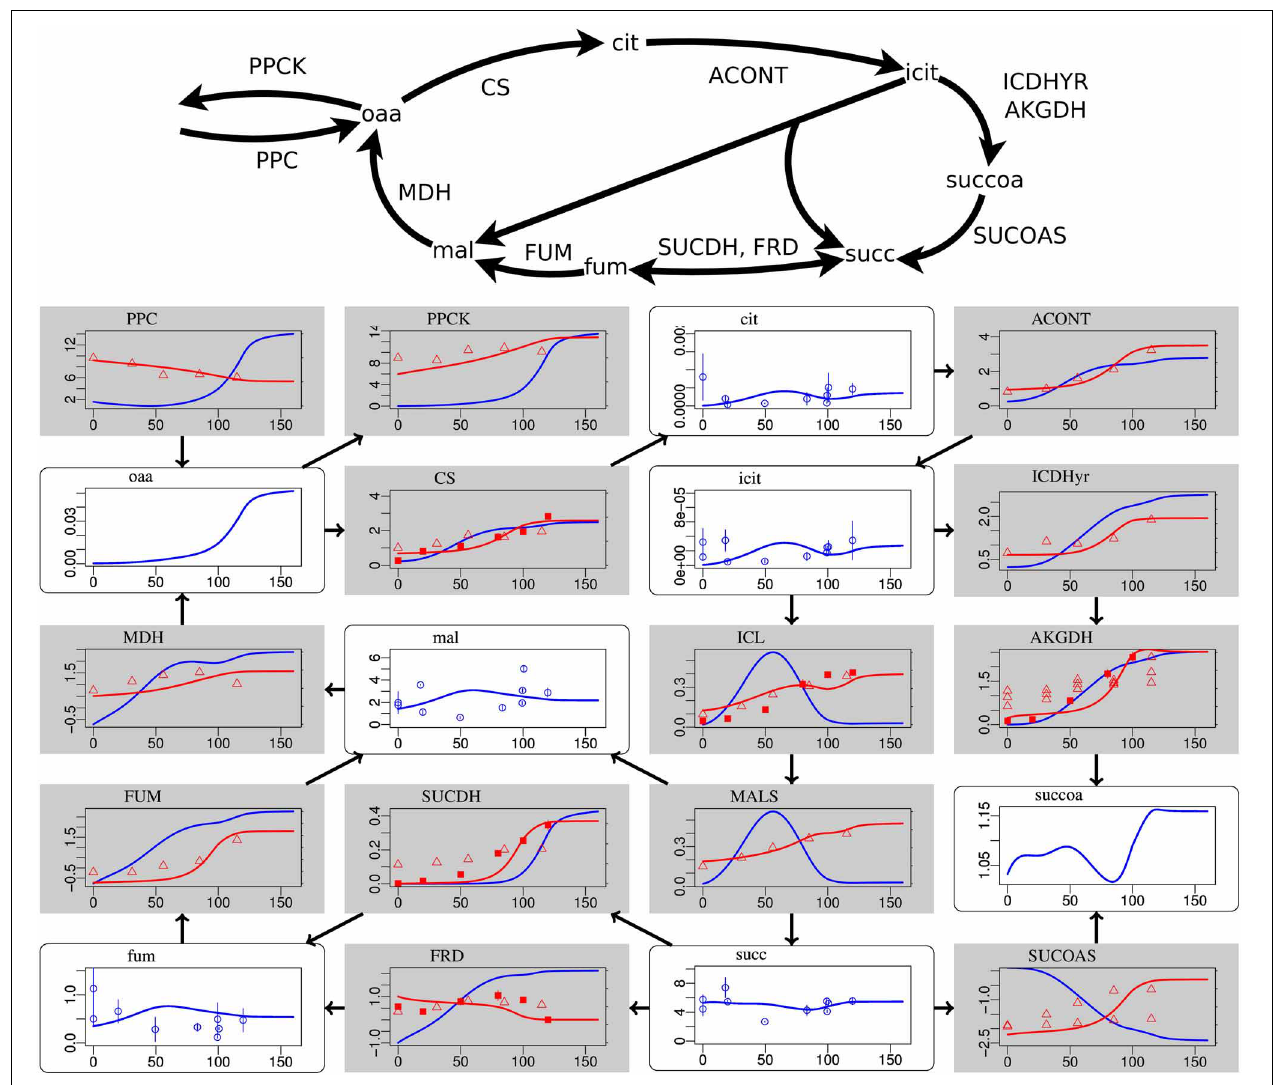
FIGURE 2 | Steady-state simulation results of the citric acid cycle in comparison to measurement data. For explanations see caption of Figure 1 . Labels from left to right and top to bottom: PPC phosphoenolpyruvate carboxylase, PPCK phosphoenolpyruvate carboxykinase, cit citrate, ACONT aconitase, oaa oxaloacetate, CS citrate synthase, icit Isocitrate, ICDHyr